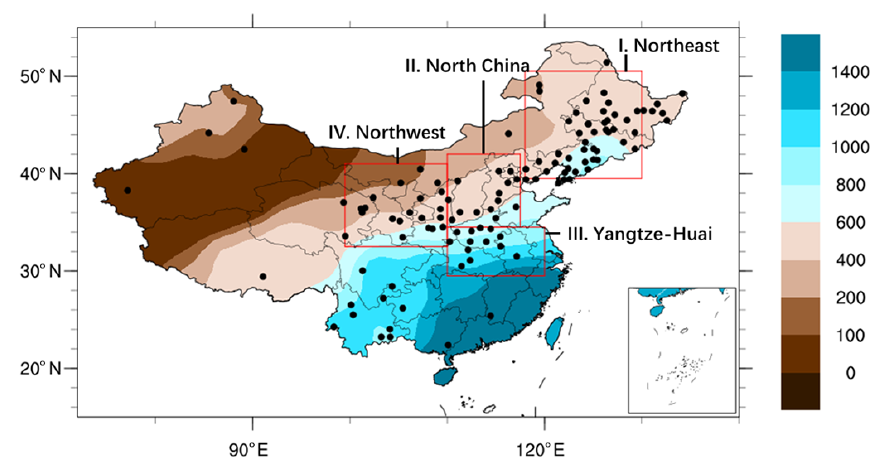
Figure 1. Spatial distribution of 119 agricultural–meteorological observation stations and four research regions over China for the period 1981 to 2013. The colors denote the distribution of annual precipitation (millimeters per annum; hereafter mma − 1 ) from